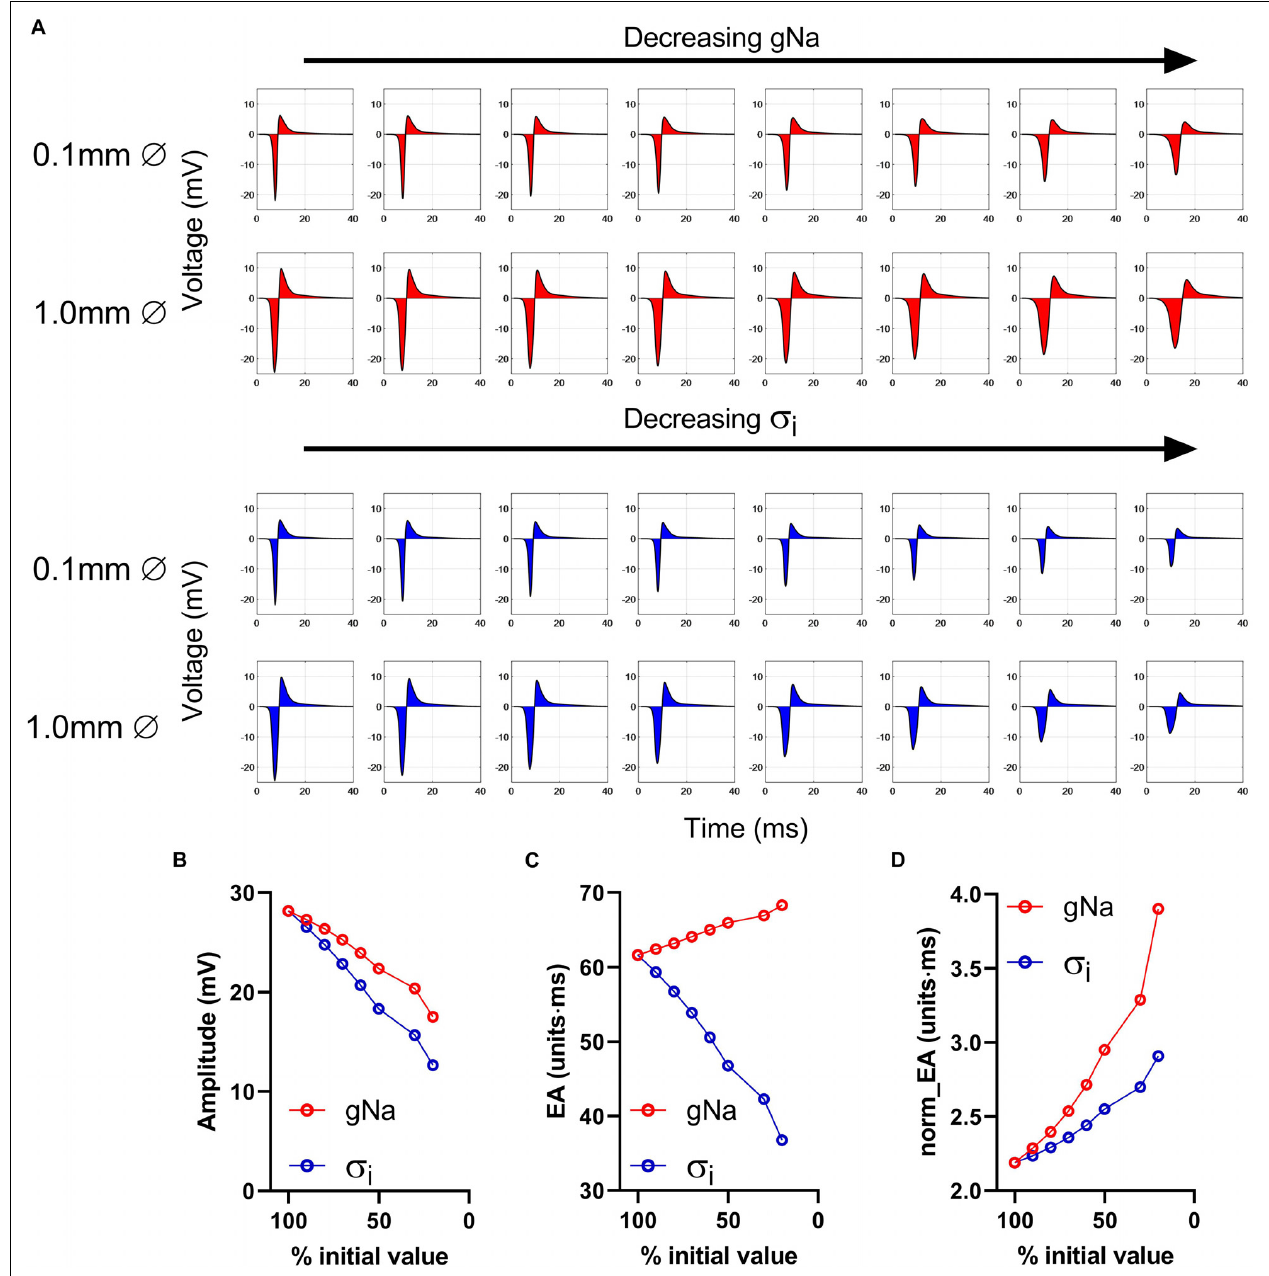
FIGURE 3 | Impact of altering sodium channel conductance and intracellular conductivity on electrogram morphology in a mouse of a propagating mose ventricular action potential. (A) Simulated bipolar electrograms with decreasing sodium channel conductance (gNa) and intracellular conductivity ( σ i). Red shading shows the calculated electrogram area. Data are shown for electrode diameters of 0.1 and 1 mm. (B–D) Data showing changing signal amplitude (B) , absolute electrogram area (EA), (C) , and (D) normalized EA (norm_EA) as a % of gNa and σ i (presented data for 0.1 mm electrode